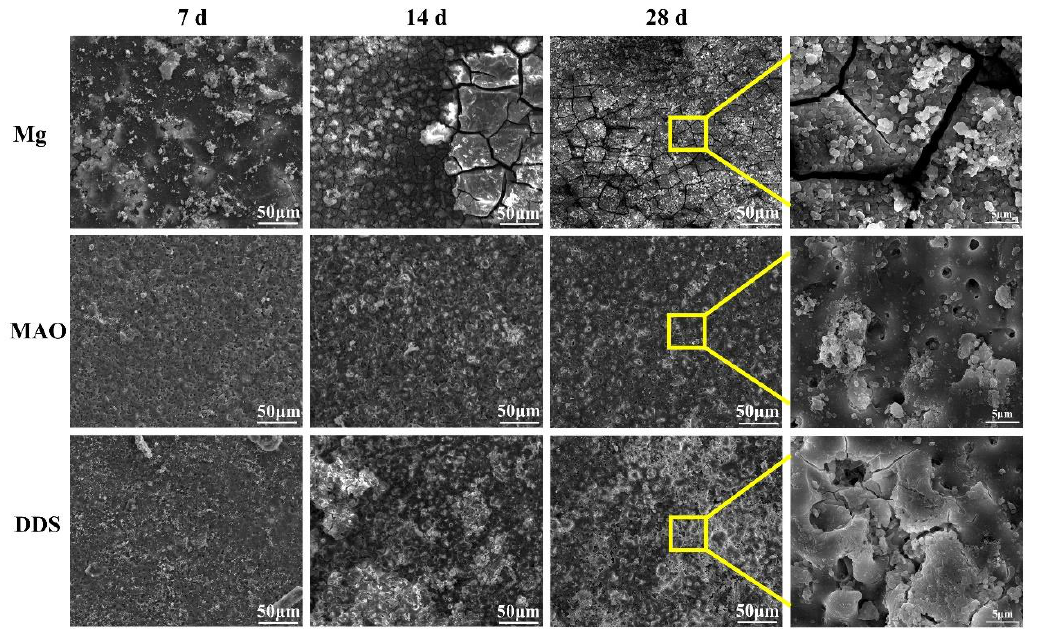
Figure 5. The surface micromorphology of Mg alloy, Mg-based MAO alloy, and Mg-based MAO-MT-PLGA DDS after immersion in Hank’s solution for 7 days, 14 days, and 28 days. The yellow squares shows enlargement of the marked area.